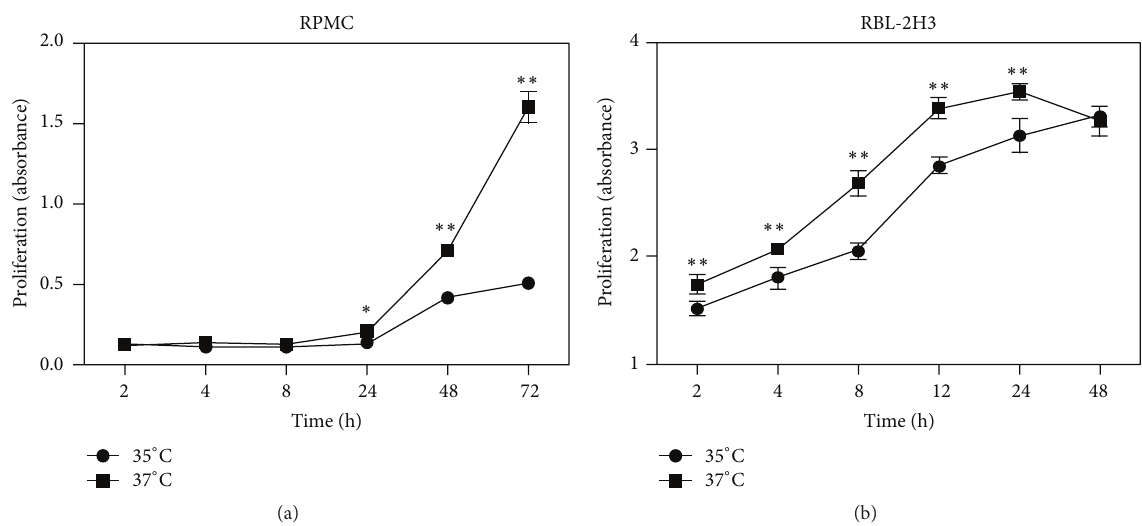
Figure 3: Growth curve of mast cells under different culture temperatures. Rat peritoneal mast cells (RPMC) (a) and RBL-2H3 (b) were cultured at 35 ∘ C or 37 ∘ C as indicated and cell proliferation was recorded. Data are expressed as the means ± SE ( 𝑛 = 6 ), representing at least three separate experiments. ∗ 𝑃 < 0.05 ; ∗∗ 𝑃 < 0.01 , compared between the two groups at the same time